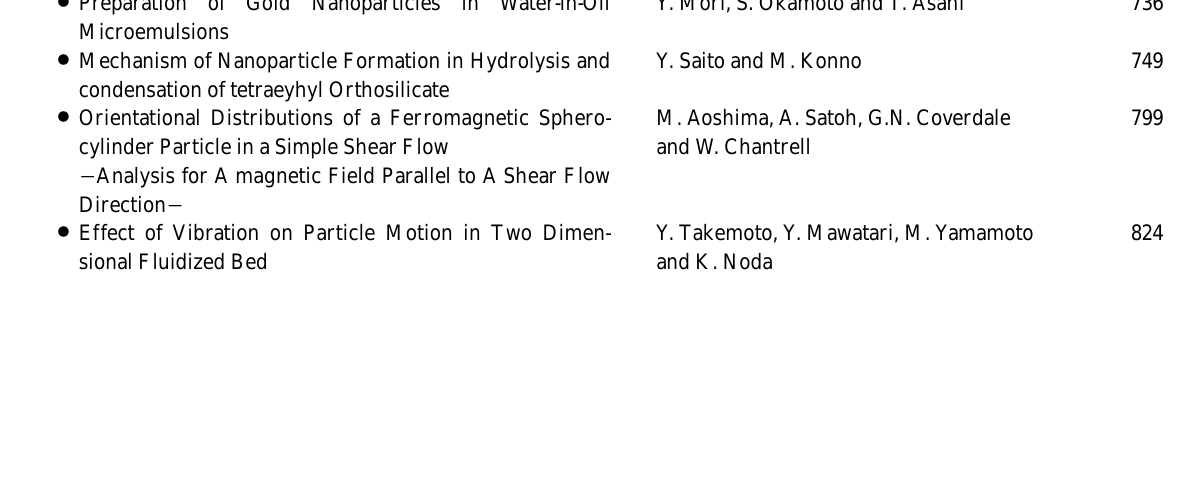
Microemulsions (cid:2) Mechanism of Nanoparticle Formation in Hydrolysis and condensation of tetraeyhyl Orthosilicate (cid:2) Orientational Distributions of a Ferromagnetic Sphero- cylinder Particle in a Simple Shear Flow